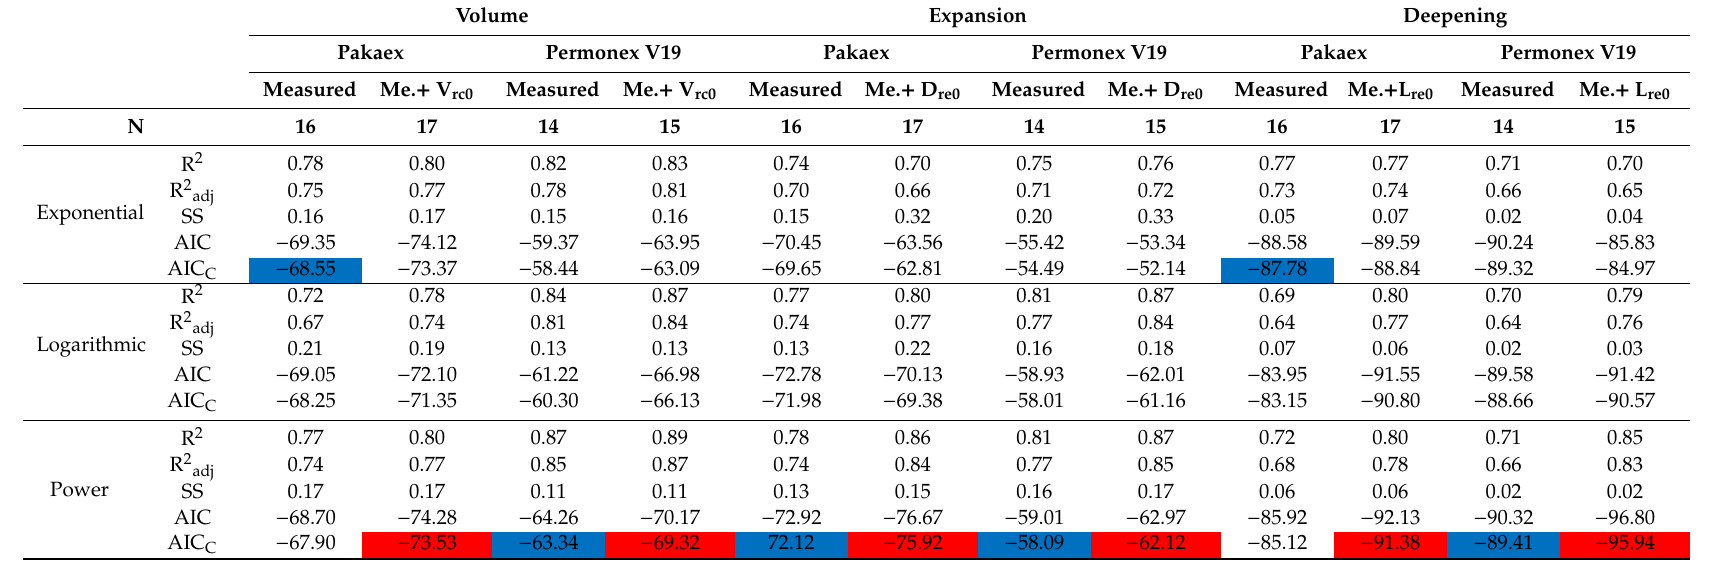
Table 5. The values of the comparison measures. Blue is the lowest AIC c value for the measured data. Red is the lowest AIC c value for the measured data + V rc0 , D re0 and L